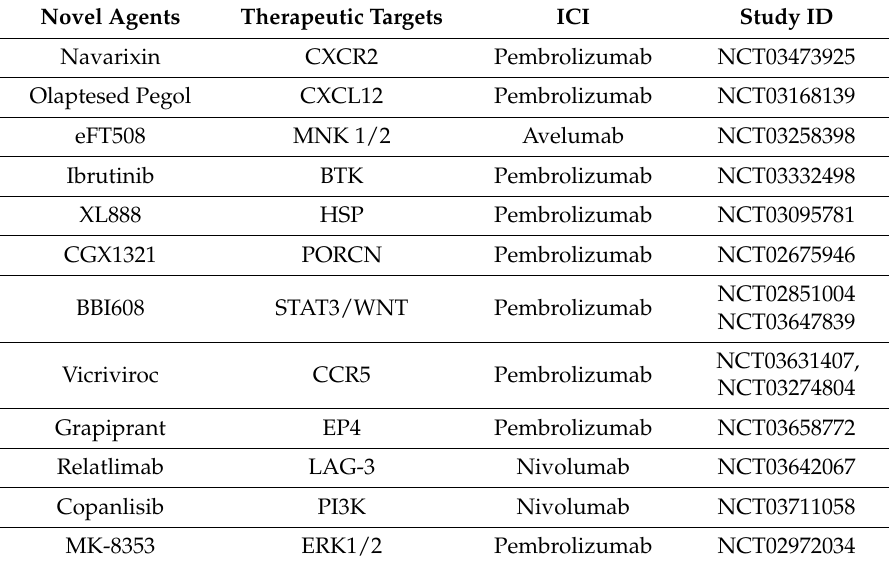
Table 5. Novel combination therapies in MSS